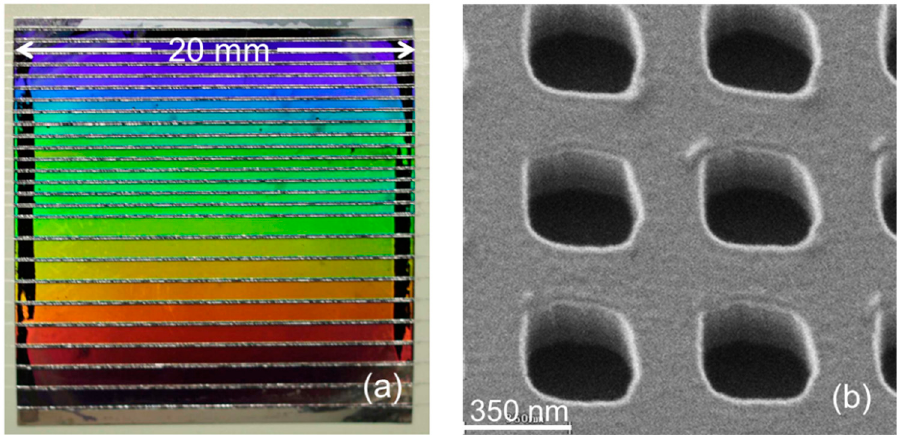
Figure 4. Microcavity filament: ( a ) 20-mm-squared Ta substrate and its split into strips using a dicing-saw process and ( b ) scanning ion microscope (SIM) image of the microcavity. The horizontal scale bar is 350 nm.